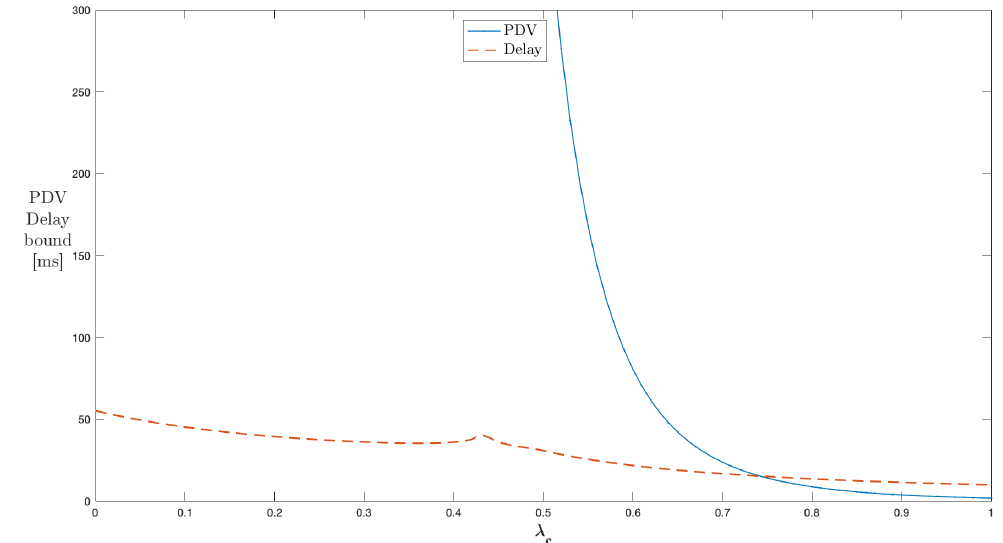
Figure 5. Impact of λ c on the PDV bound in a single-stage network (constant µ c ).